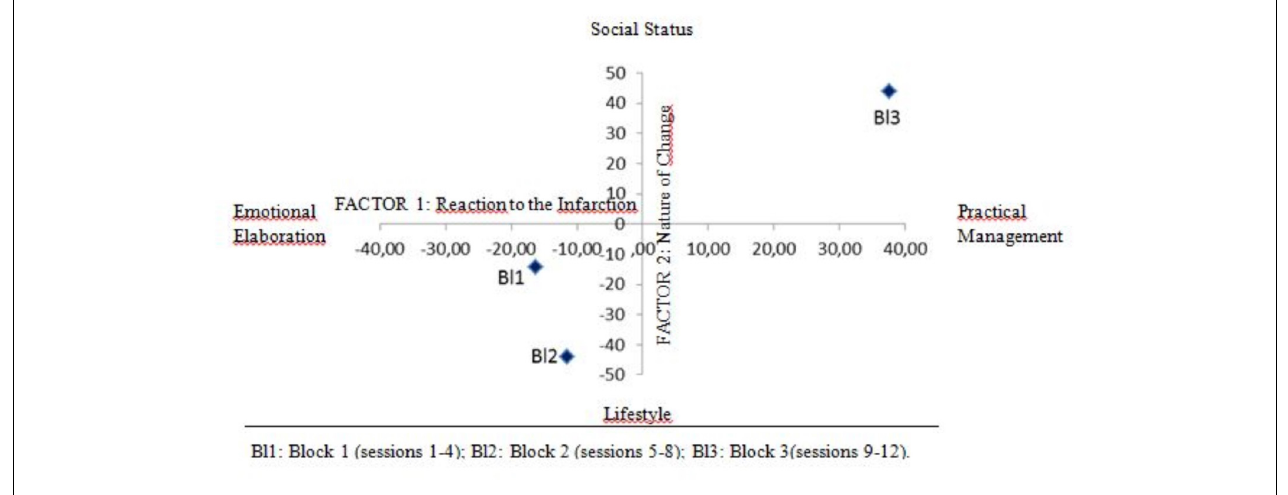
FIGURE 1 | Position of the temporal blocks along the two factorial